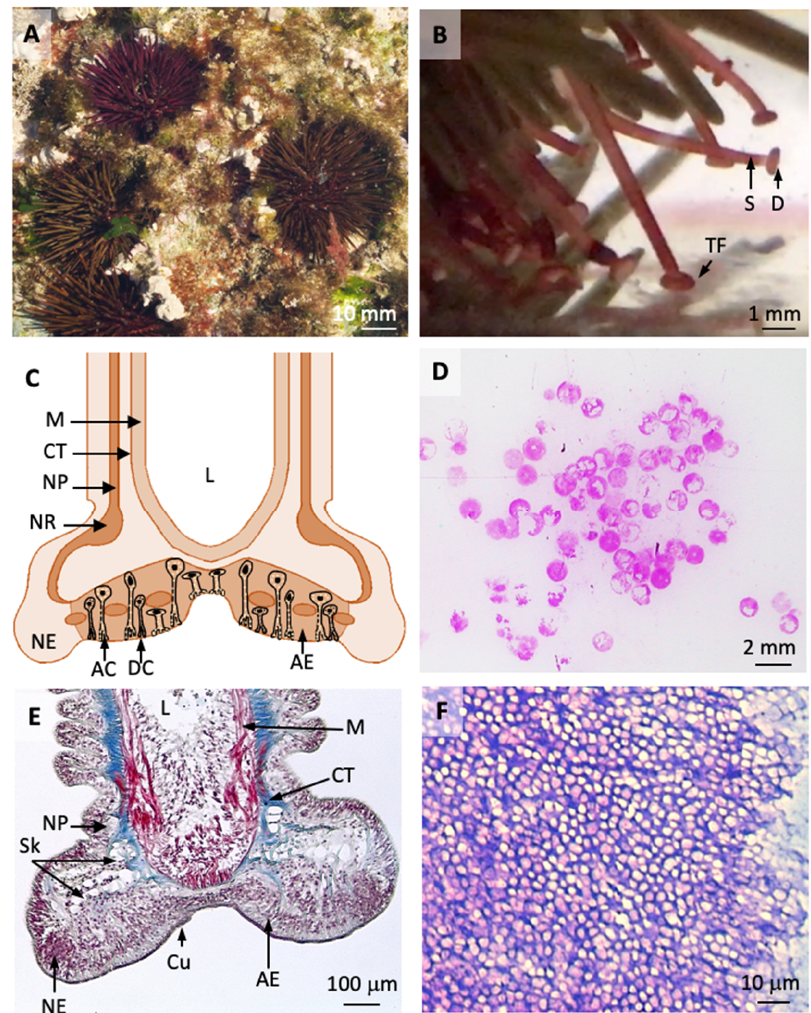
Figure 1. Rock-boring sea urchin Paracentrotus lividus ( A ) has hundreds of oral tube feet specialized for locomotion and adhesion ( B ). Tube feet have a proximal cylindrical motile stem and a distal flattened disc with a duo-glandular adhesive epidermis with adhesive and de-adhesive secretory cells ( C , E ). After detachment, circles of adhesive secretion remain attached to the substrate and can be visualized after staining with an aqueous solution of Crystal Violet ( D , F ). Abbreviations: AC, adhesive secretory cell; AE, adhesive epidermis; CT, connective tissue; Cu, cuticle; D, disc; DC, de-adhesive secretory cell; L, lumen; M, myomesothelium; NE, non-adhesive epidermis; NP, nerve plexus; NR, nerve ring; S, stem; Sk, skeleton; TF, tube feet.